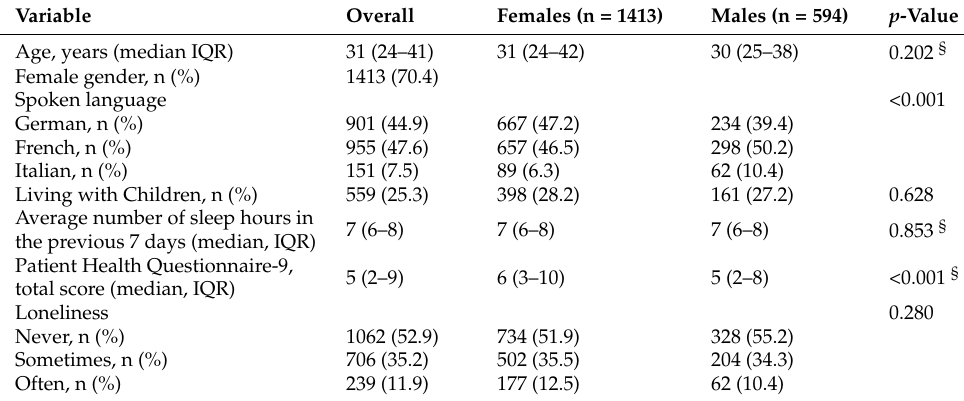
Table 1. Characteristics of the 2007 study